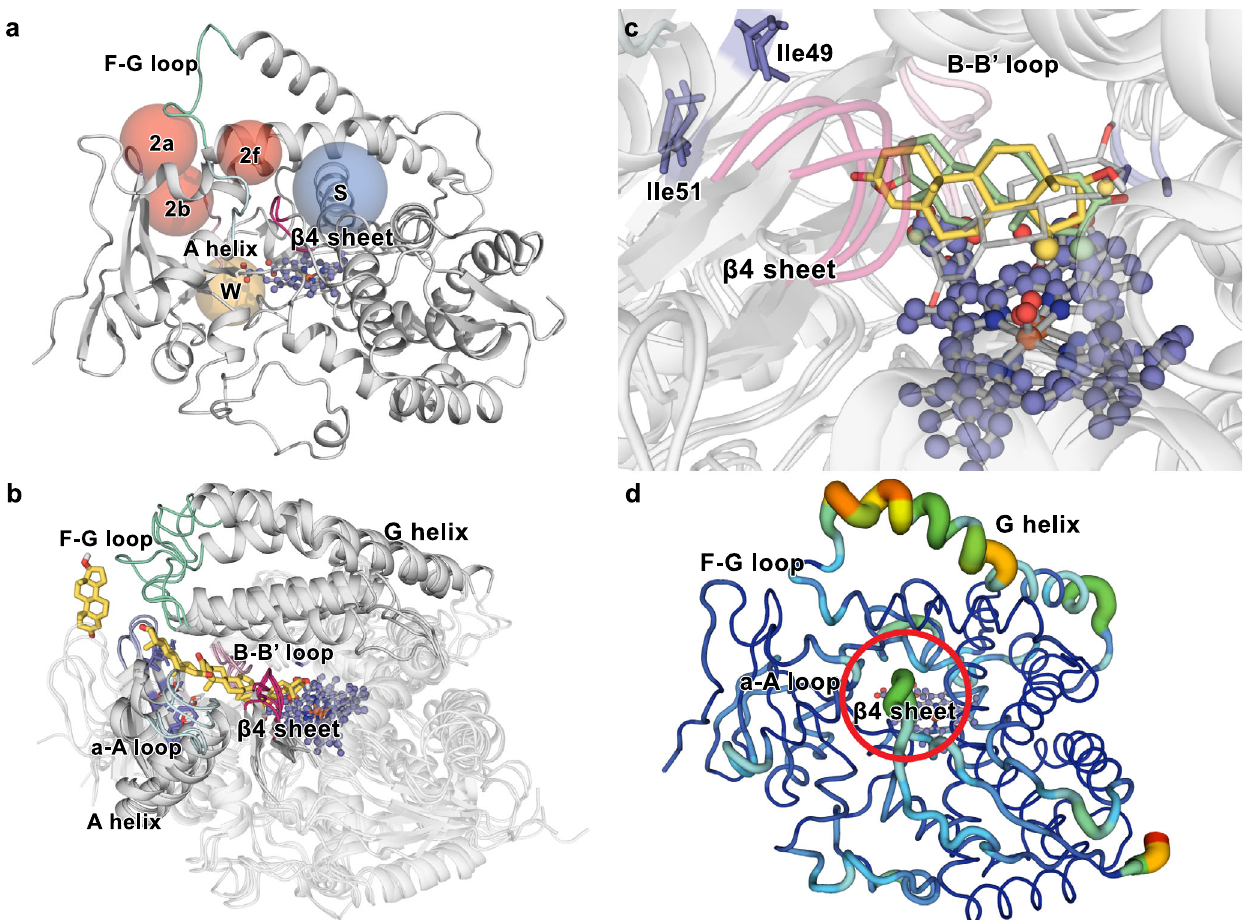
Fig. 4 Secondary structural elements determining regioselectivity and activity. a Spheres indicate the channels observed in the WT crystal structure (PDB: 1FAG) and in the mutants of our MD simulations (red and blue colour). b Trajectories of 1 towards the active site of mutant I-- and binding of 1 above the haem. c Rotation of 1 from pose15 to pose2 in the active site of mutant III. β Hydrogens belonging to C2 and C15 atoms are depicted in pale green and yellow colour, respectively. d Principal Component Analysis (pc2) of mutant III (APO). The thickness of the line is proportional to the motion and the colour scale varies from blue (minimum motion) to red (maximum motion). The β 4 sheet is highlighted with a red circle. Standard nomenclature for channels 69 and secondary structure elements 70 is